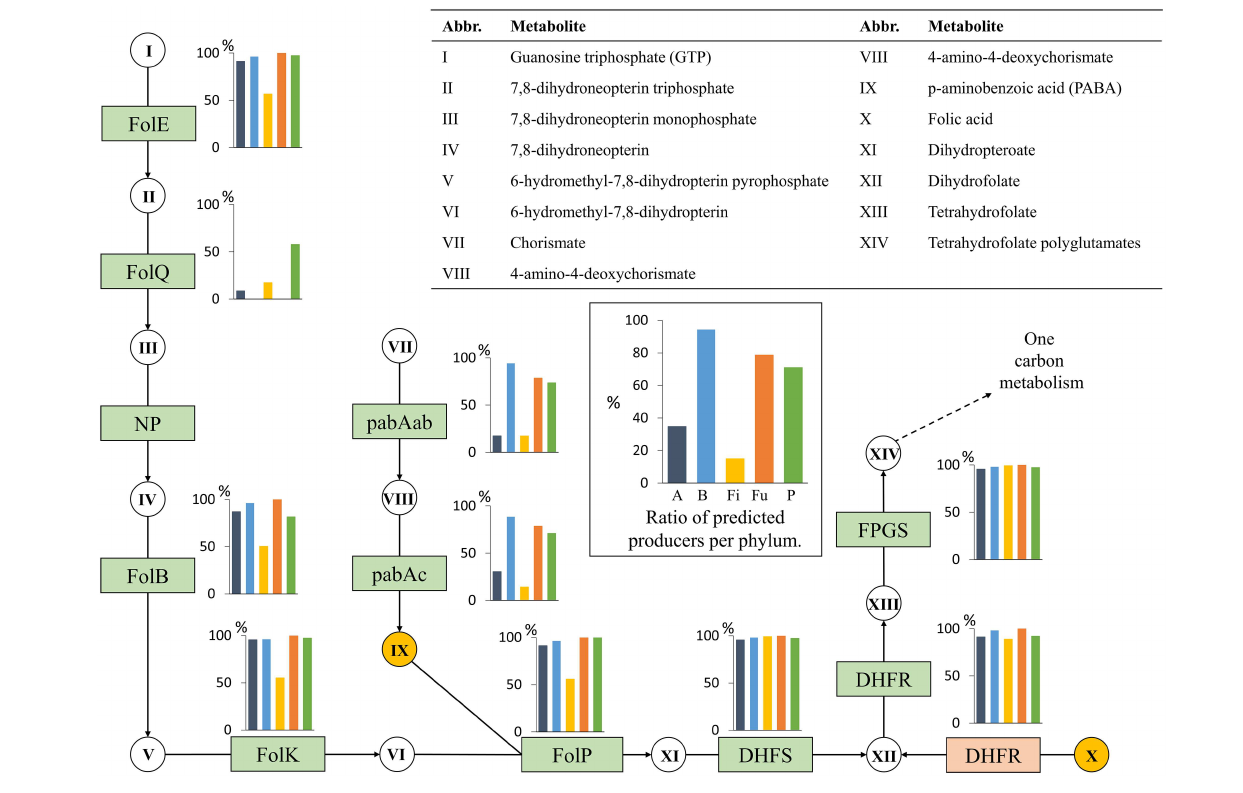
Frontiers in Genetics |